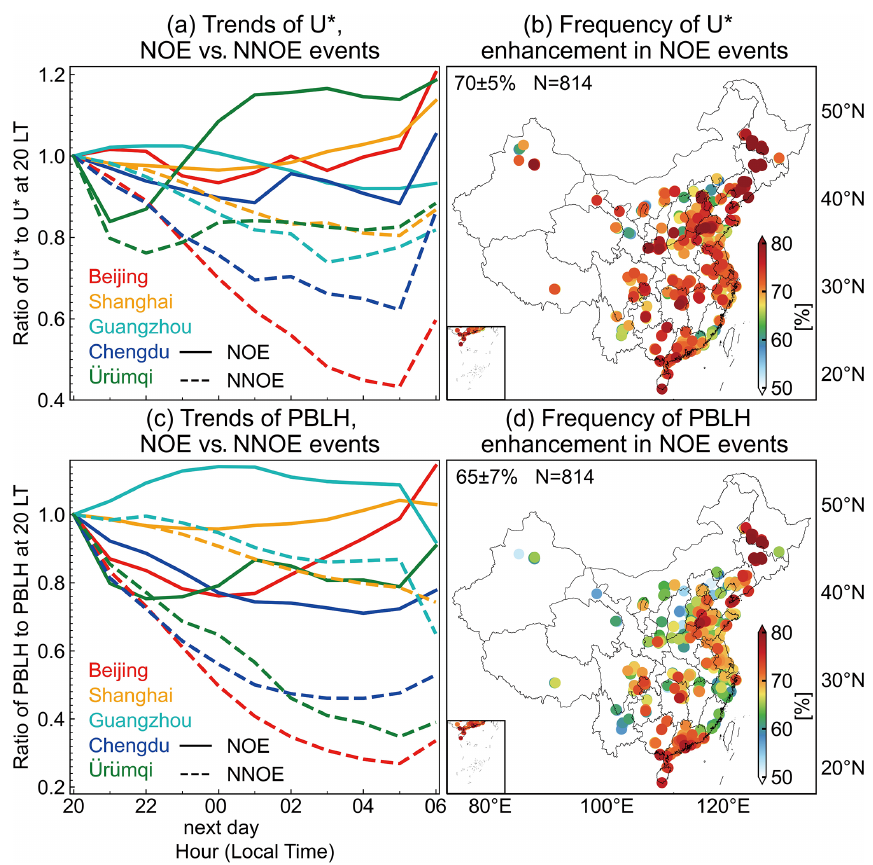
Figure 6. Increases in the friction velocity ( U ∗ ) and planetary boundary layer height (PBLH) during NOE events. Panels (a) and (c) shows the nighttime evolution of the U ∗ and PBLH, scaled by the values at 20:00LT, averaged over all NOE and NNOE events in the five representative cities. The absolute values of the U ∗ and PBLH are shown in Fig. S5. Panels (b) and (d) show the frequency of the U ∗ and PBLH increase within the 2h prior to the occurrence of an NOE event at the individual sites. The regional means and standard deviations among the N sites are shown inset. The U ∗ and PBLH data are from the ERA5